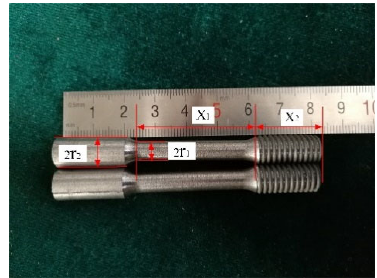
Figure 3. Tensile specimen of the SiCp/Al composite.